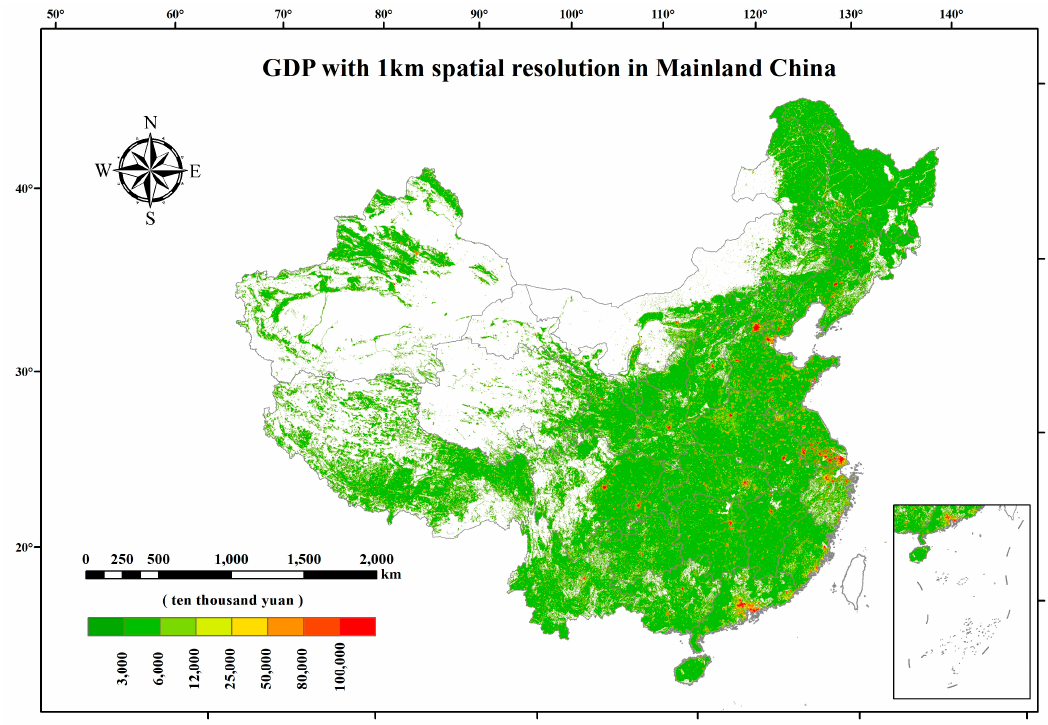
Figure 3. Gridded Gross Domestic Product (GDP) in mainland China in 2014 with a spatial resolution of 1 km. Blank in the figure means areas without GDP.